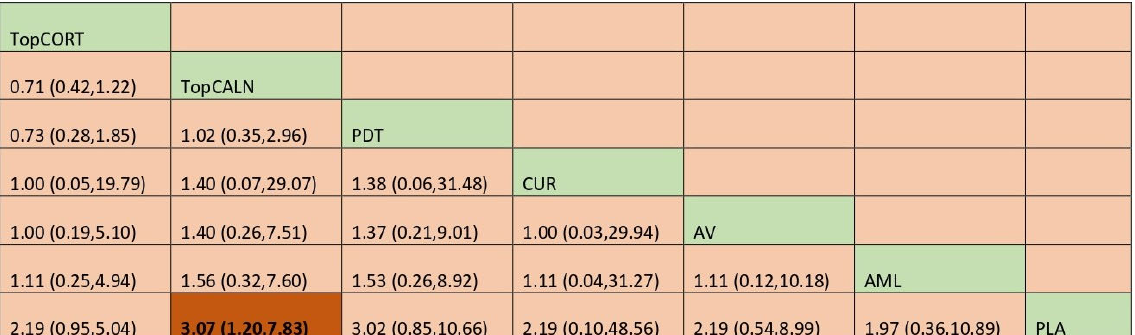
Figure 9. League table for adverse effects. Abbreviations: AML, amlexanox paste; AV, aloe vera; CUR, curcumin gel; PDT, photodynamic therapy; PLA, placebo; TopCALN, topical calcineurin; TopCORT, topical corticosteroid. The green highlights indicate the interventions and the dark highlights indicate the significant results.